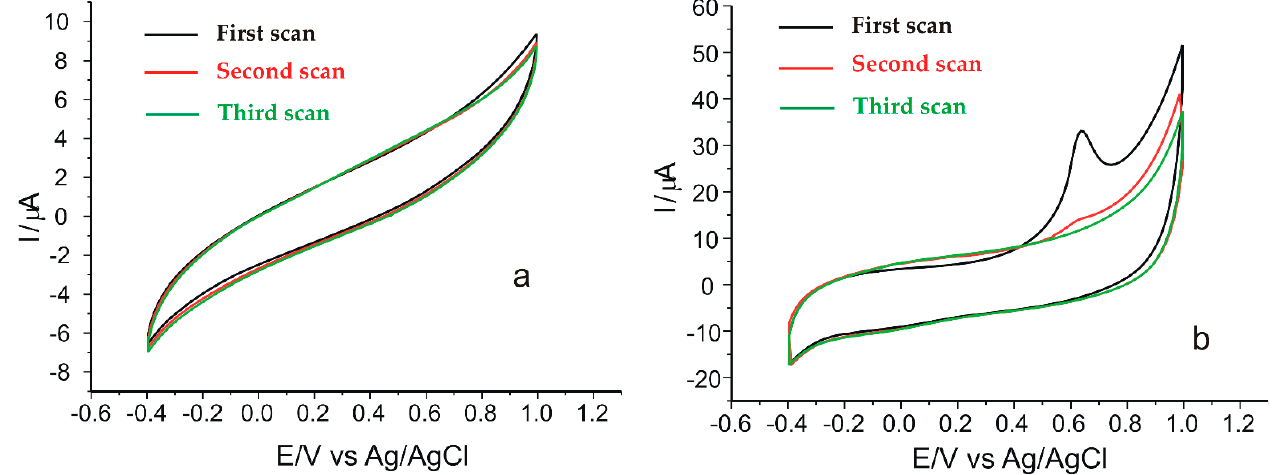
Figure 5. CVs registered in 0.1 M PBS solution by SPCE/GPHOX ( a ) and SPCE/GPHOX- Pentapeptide ( b ). Scan rate 0.05 V·s − 1 . Three successive cycles.